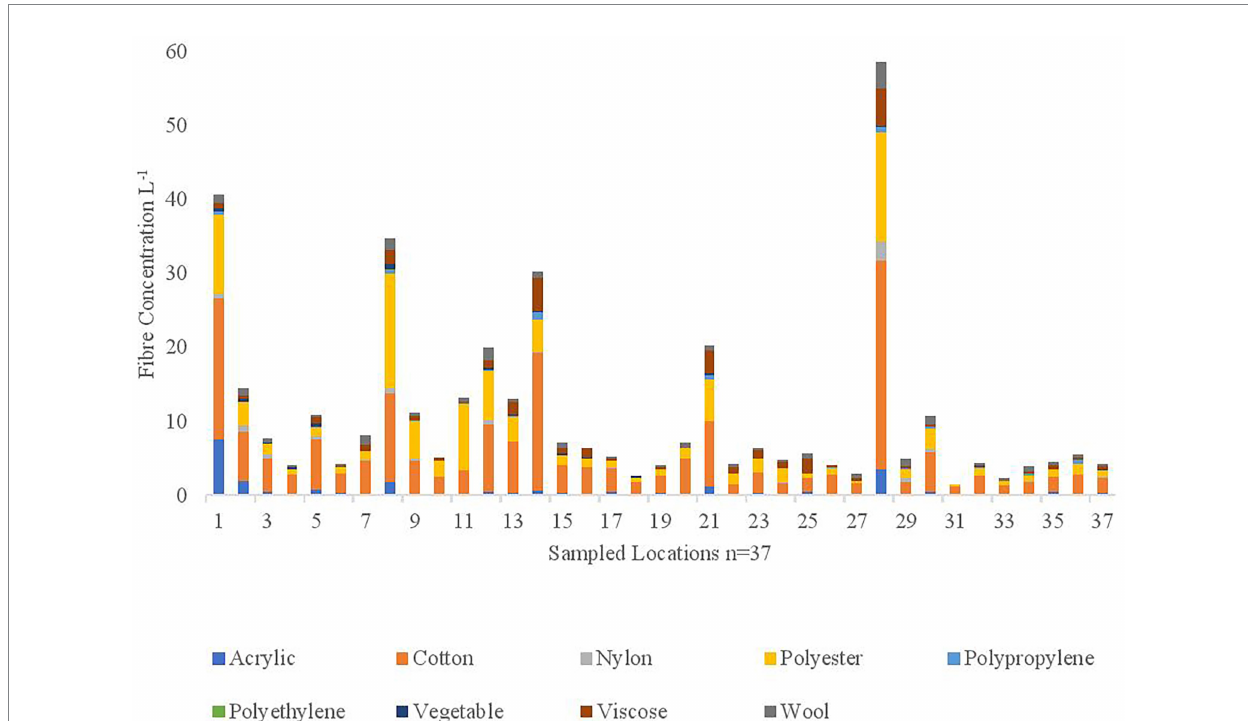
FIGURE 3 Concentration of fibre types identified across 37 sampled locations along the Kenyan